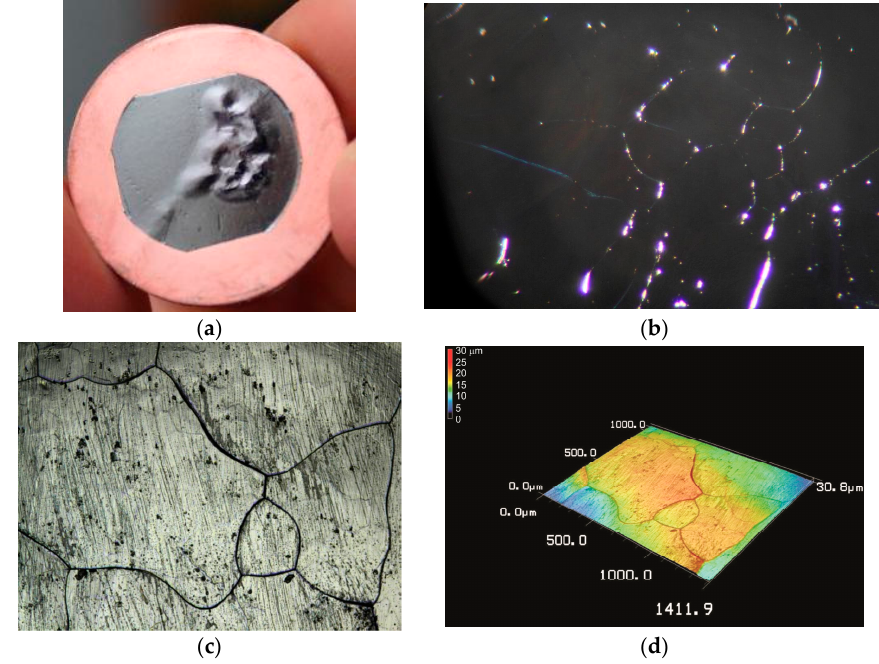
Figure 8. Images of the sample after irradiation taken by the ( a ) camera; ( b ) a camera through the optical; ( c ) laser and ( d ) the results of laser microscope signal processing. The frame size is ( c , d ) 1411.9 × 1000 μ m 2 ; the height is ( d ) 30.8 μ m.